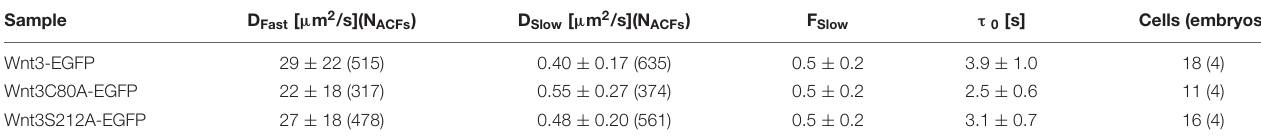
TABLE 2 | SPIM-FCS and SPIM diffusion law results for Wnt3-EGFP, Wnt3C80A-EGFP and Wnt3S212A-EGFP. Sample